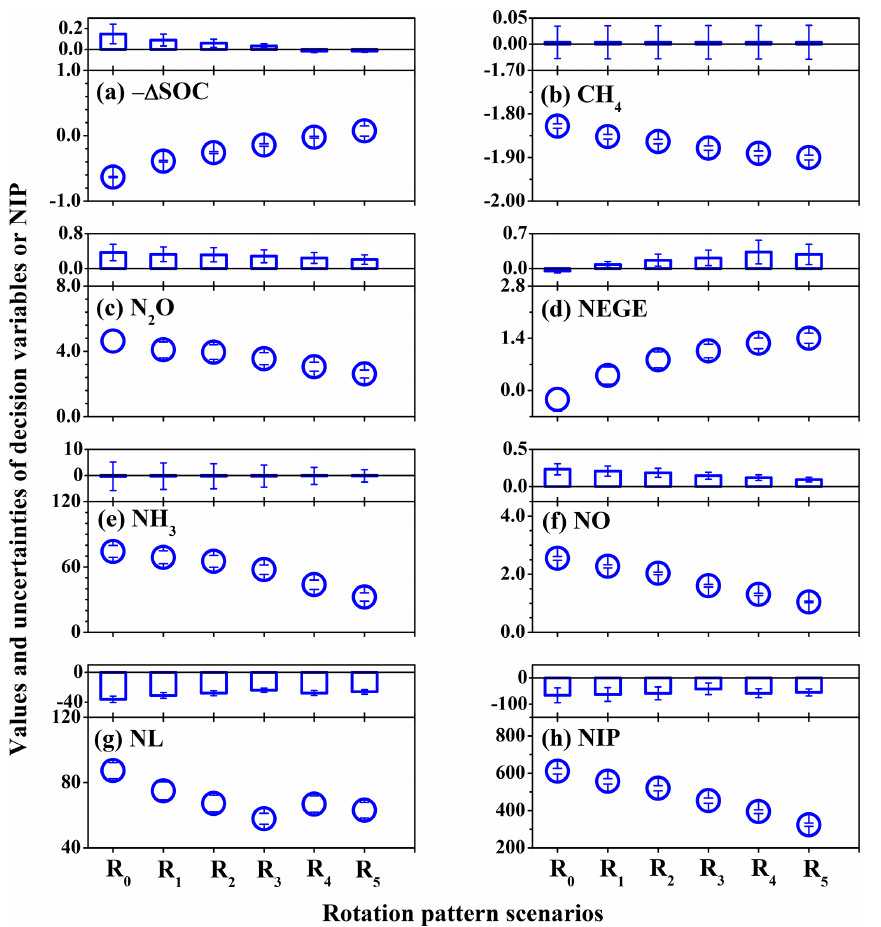
Figure 4. Simulated effects of various rotation patterns between a cotton and winter wheat–summer maize cropping system with a 6-year cycle on decision variables and the negative impact potential (NIP). The subscript numbers in R 0 , R 1 , ..., R 5 refer to the number of con- secutive years of cotton cultivation. The y axis units are megagrams of carbon per hectare per year (MgCha − 1 yr − 1 ) for the opposite of the mean annual increase in soil organic carbon stock ( − (cid:49) SOC), kilograms of carbon per hectare per year (kgCha − 1 yr − 1 ) for methane (CH 4 ) emissions, kilograms of nitrogen per hectare per year (kgNha − 1 yr − 1 ) for fluxes of nitrous oxide (N 2 O), ammonia (NH 3 ), nitrous oxide (NO), and nitrate leaching (NL), megagrams of carbon dioxide equivalent per hectare per year (MgCO 2 eqha − 1 yr − 1 ) for net ecosys- tem aggregate greenhouse gas emission (NEGE), and US dollars per hectare per year (USDha − 1 yr − 1 ) for NIP. The CO 2 eq was based on the 100-year global warming potentials, i.e., 34 for CH 4 and 298 for N 2 O (IPCC, 2013). The NIP was calculated using Eq. (7), which is presented in the text. The vertical bar within the open circle of each datum point indicates the absolute uncertainty (1 SD) introduced by the input uncertainties of key soil properties. Each unfilled column indicates the absolute total uncertainty of the simulation, with its vertical bar representing its random uncertainty (1